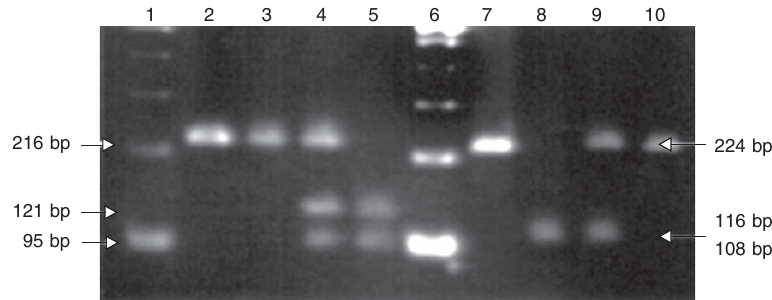
Figure 2. PCR products digested with Bsm FI ( lanes 3 , 4 , 5 ) and Hha I ( lanes 8 , 9 , 10 ) were separated on 2.5% agarose gel stained with ethidium bromide. Lanes 1 and 6 , 100-bp DNA ladder. Lanes 2 and 7 , undigested PCR products. Lane 3 , CC homozygote. Lane 4 , C/T heterozygote. Lane 5 , TT homozygote. Lane 8 , GG homozygote. Lane 9 , G/A heterozygote. Lane 10 , AA homozygote. Note that the 116- and 108-bp fragments cannot be distinguished on the 2.5% agarose gel but genotyping is clear by comparison with